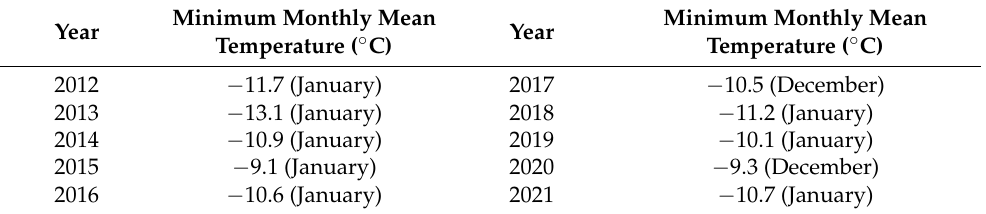
Table 2. Minimum monthly mean temperatures at Bonghwa-gun, Gyeongsangbuk-do, Korea in the last 10 years. (Weather data from the Korea Meteorological Administration [17]).